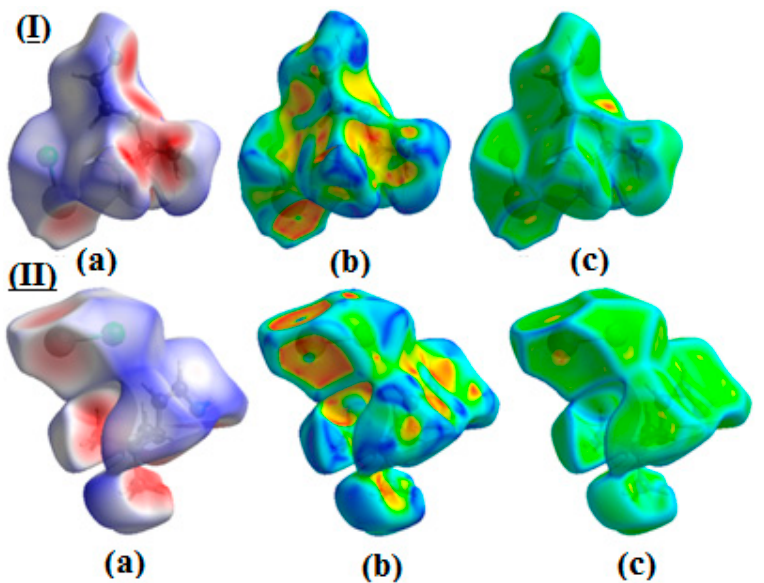
Figure 5. HS cartography showing d norm ( a ), shape index ( b ), and curved ness surface ( c ) profiles for compounds ( I ) and ( II ) .